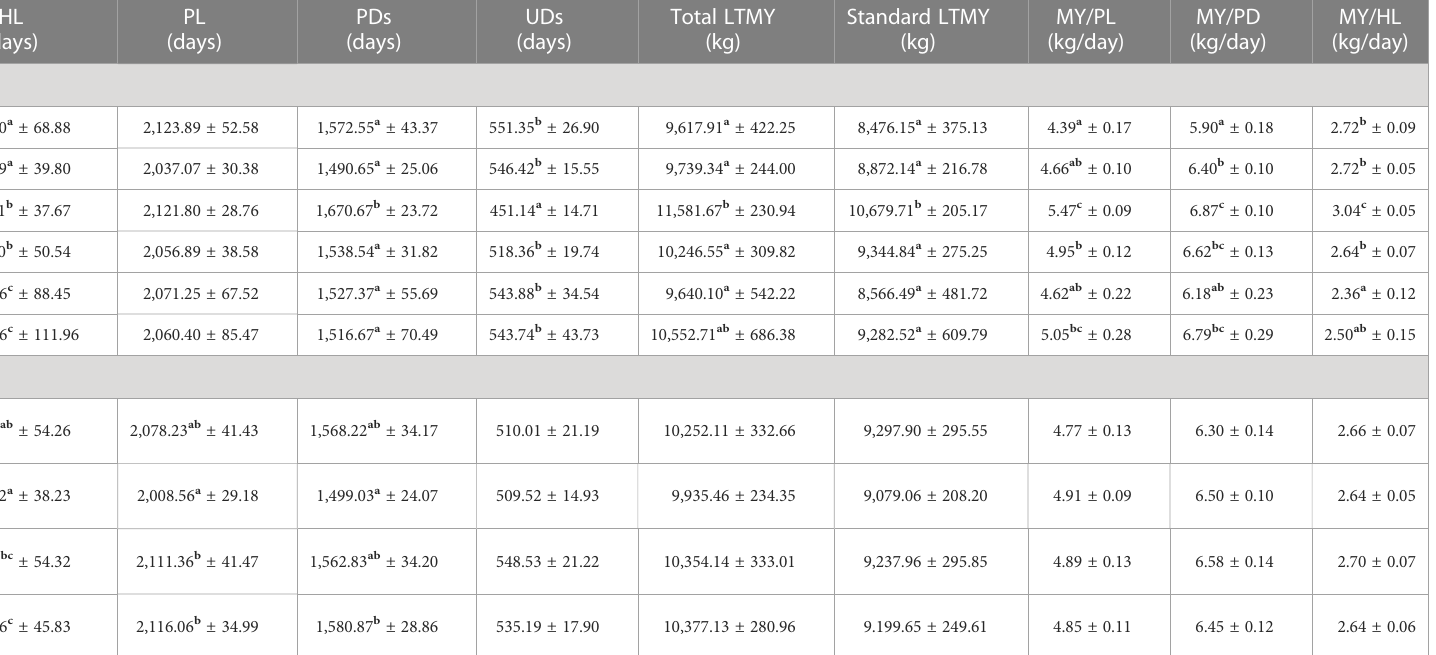
HL,herdlife;PDs,productivedays;PL,productivelife;standardLTMY,standardlifetimemilkyield;MY/HL,milkyieldperdayofherdlife;MY/PDs,milkyieldperdayofproductivedays;MY/PL,milkyieldperdayofproductivelife;UDs,unproductivedays,totalLTMY,total lifetime milk yield. Means bearing different superscripts in a column differ signi fi cantly.